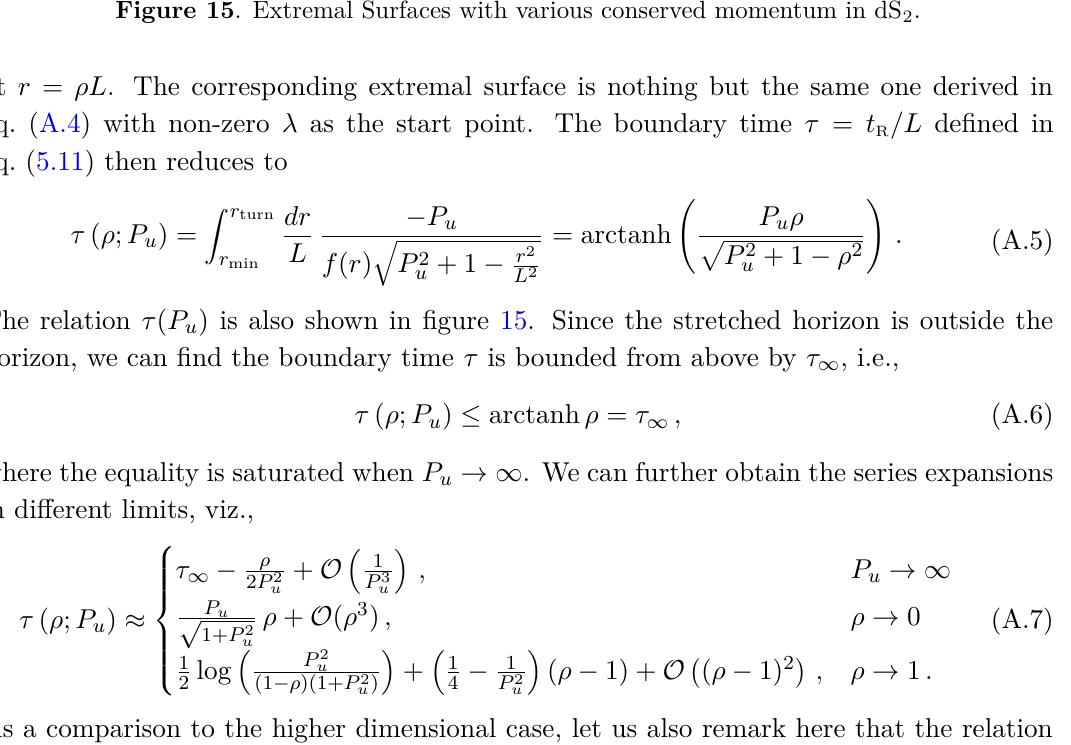
Figure 15 . Extremal Surfaces with various conserved momentum in dS 2